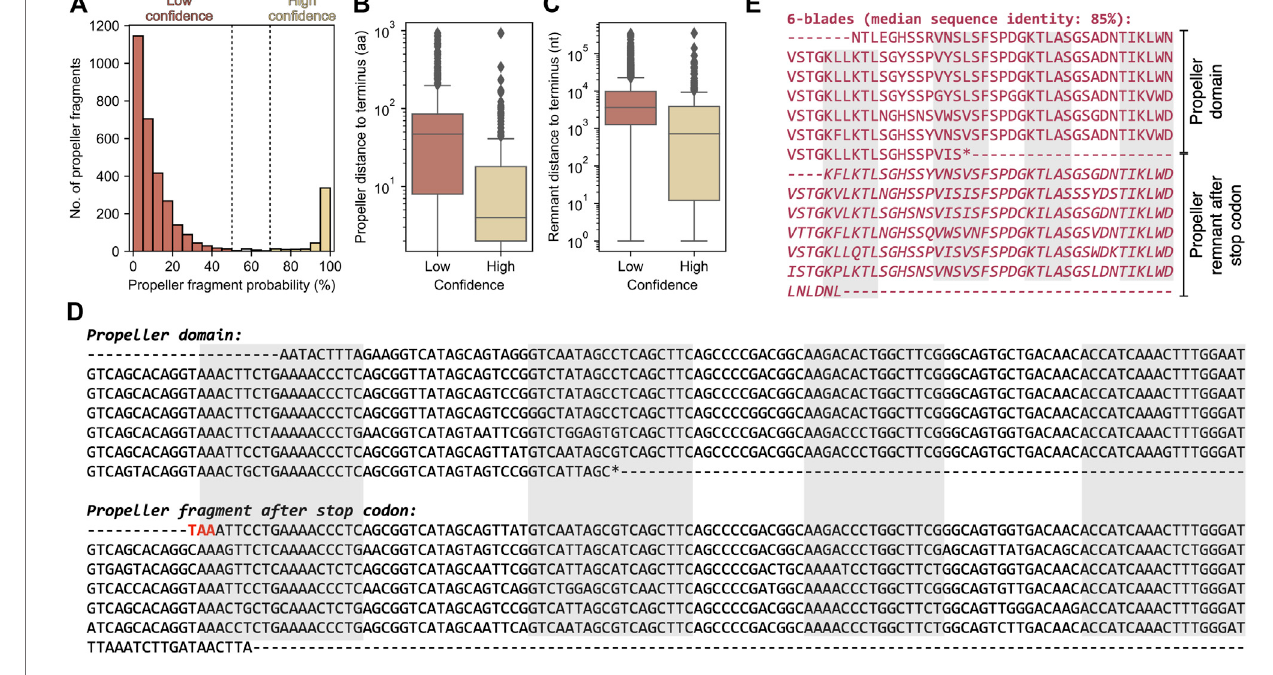
FIGURE 9 | The β -propeller fragments found in the genomic neighbourhood of globally highly repetitive β -propellers. (A) Histogram of the HHsearch probability of the identi fi ed putative fragments. Boxplots for thedistanceofthe (B) highly repetitive β -propeller(in amino acids) and (C) correspondingputative β -propeller fragment(in nucleotides)totheclosesthostprotein/geneterminus,separatedbycon fi dencelevel. (D) Nucleotidesequenceandgenomiccontextoftheexemplarygloballyrepetitive β -propeller from Nostoc sp. HK-1 hypothetical WD40 repeat-containing protein BBD61132.1. The starting codon is highlighted in blue and in frame, disruptive, stop codons in red. The regions coding for the strands making up the different blades are highlighted in grey. (E) Amino acid sequence of the 6 highly similar blades annotated at the C-terminus of BBD61132.1 plus the additional 6 found beyond the stop codon (and that make the β -propeller fragment).